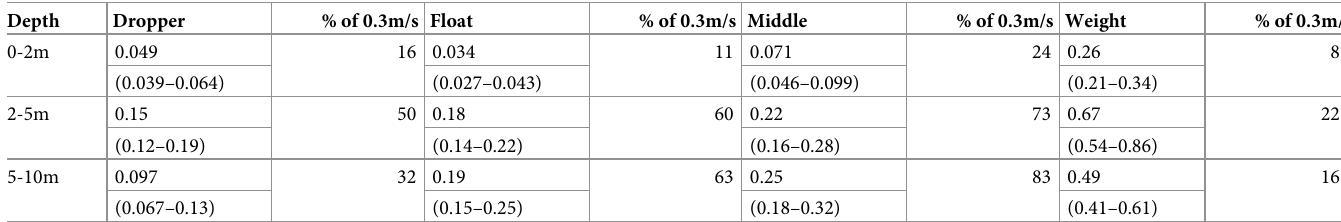
Table 3. Estimated sinking speed across different water depth ranges expressed as the average sink rate (m/s) at each TDR location together with 95% CRI in brackets. Depth Dropper % of 0.3m/s Float % of 0.3m/s Middle % of 0.3m/s